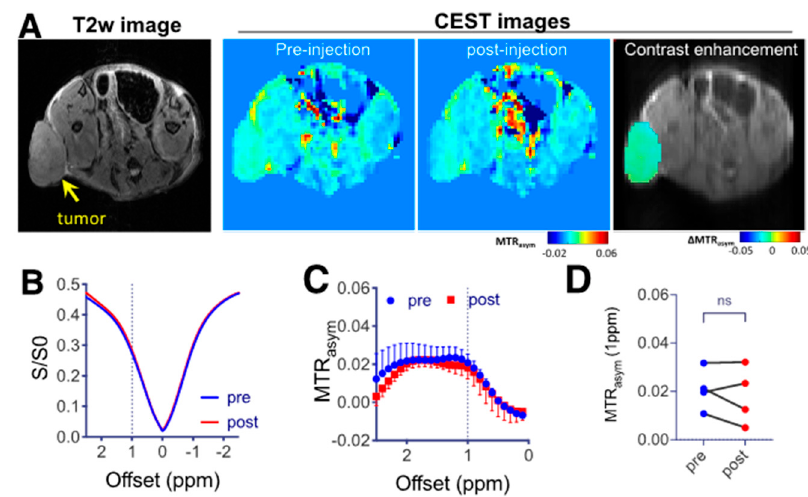
Figure 5. CEST MRI of CT26 tumors in mice receiving LNT-SeNPs. ( A ) T2w image (left), CEST contrast images pre and 1 h post injection of LNT-SeNPs (middle) as quantified by MTR asym at 1 ppm, and an overlay image showing the CEST contrast enhancement in the tumor region on the top of T2w image of a representative mouse. ( B ) Mean Z-spectra and ( C ) mean MTR asym plots of four tumor ROI values. ( D ) Scatter plot of the mean tumor ROI values before and after LNT-SeNP injection (n = 4).